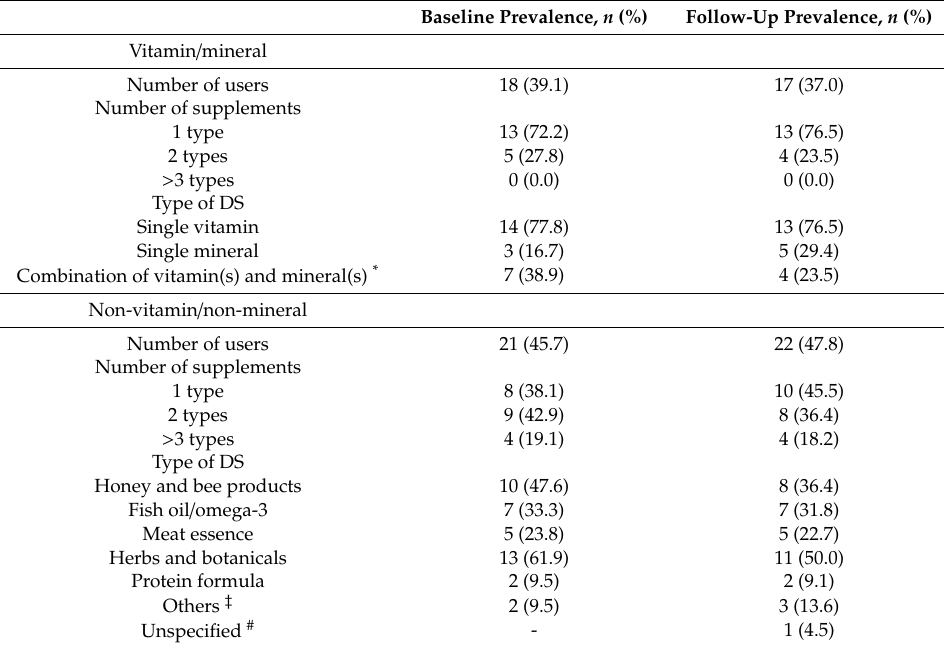
Table 2. Descriptive data on the baseline administration and